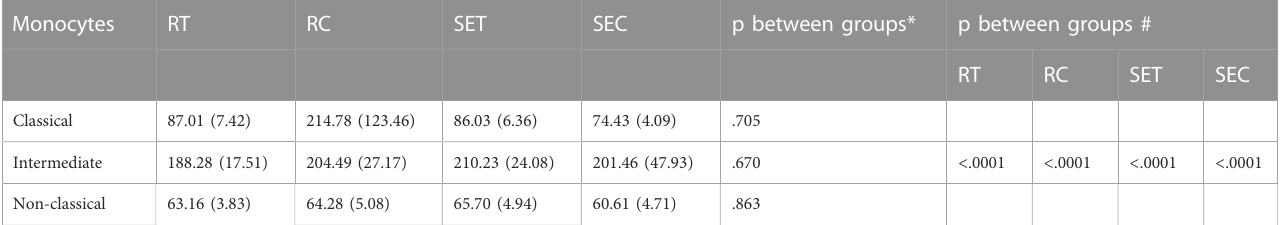
TABLE 8 Level of expression (a.u.) of the receptor CCR2 in monocyte subtypes, according to the treatment arms. Monocytes RT RC